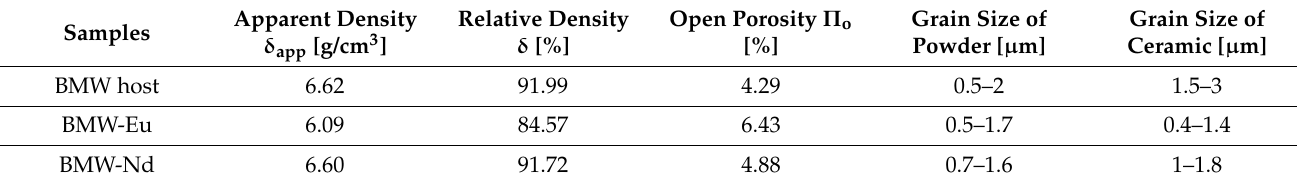
Table 1. Statement of density parameters of ceramic materials determined by the Archimedes method.